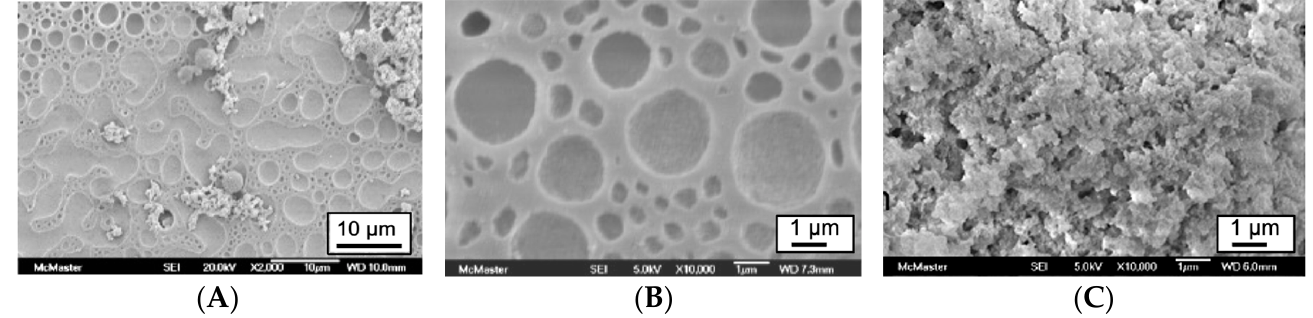
Figure 3. As-prepared ( A ) upper gel surface from recipe 6 (Table 1) (scale bar 10 microns); ( B ) higher magnification of A (scale bar 1 micron); ( C ) the same sample calcined at 600 °C 1200–1400 m 2 g − 1 (see also Figure S1).